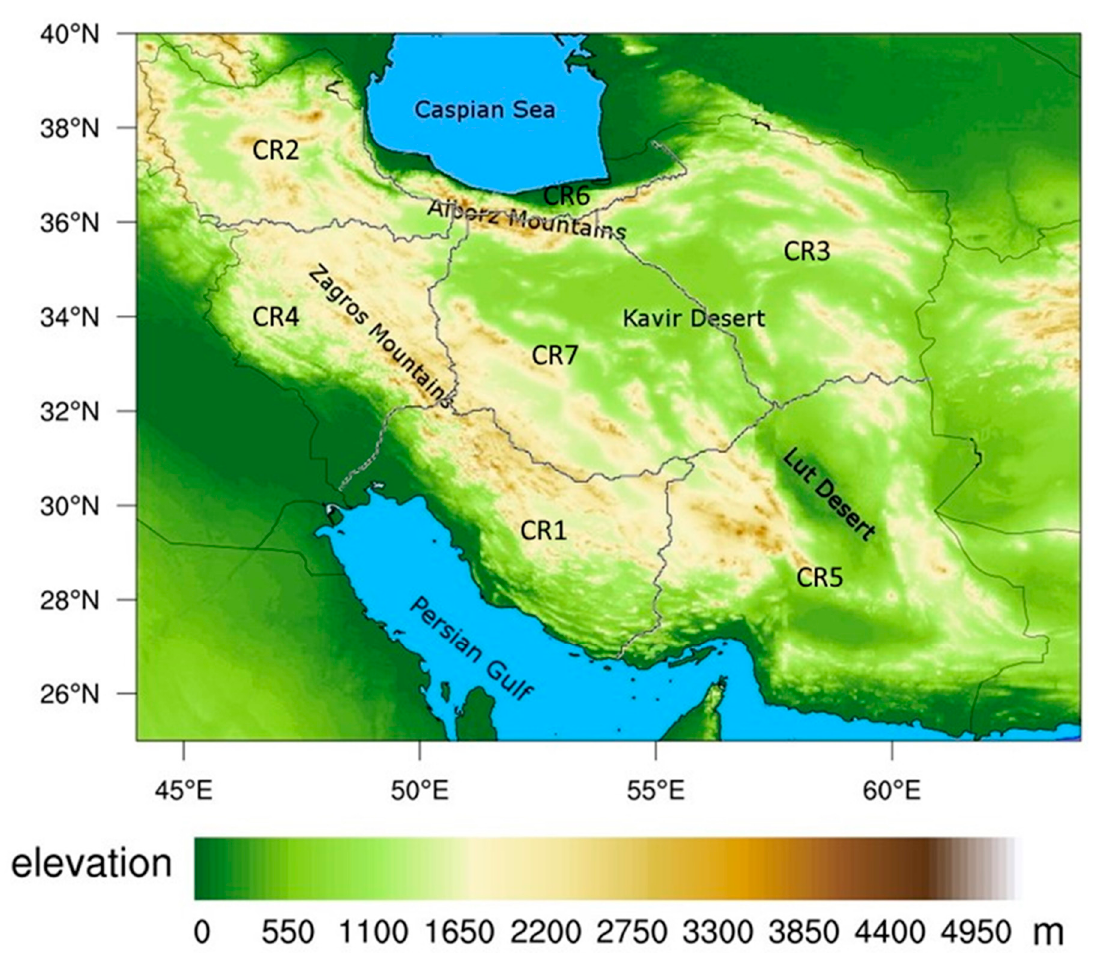
Figure 1. The topography map of Iran and the seven climate regions.